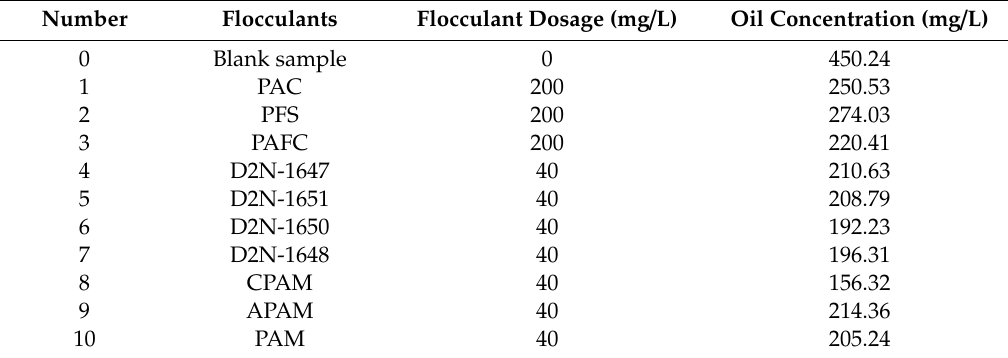
Table 4. Treatment e ffi ciencies of di ff erent flocculants on produced water.